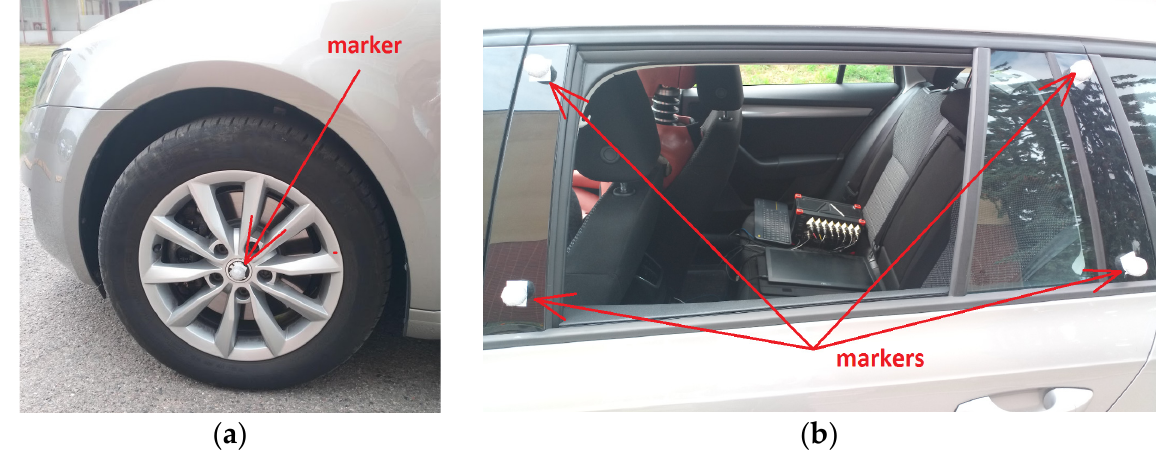
Figure 6. Markers placed on the vehicle: ( a ) wheel of the vehicle and ( b ) body of the vehicle. Acceleration and position sensors were connected to MMF preamplifiers: Dewetron MSI-BR-ACC-S1 and SMS: Dewetron MSI-BR-CH-50, on each channel to the Dewesoft STGM + amplifier. The data processing device Dewesoft Siruis Sbox + battery pack was used for signal processing (the device will be placed in a car-scanning frequency of 20,000 Hz, scanned without the use of built-in HW signal filters).